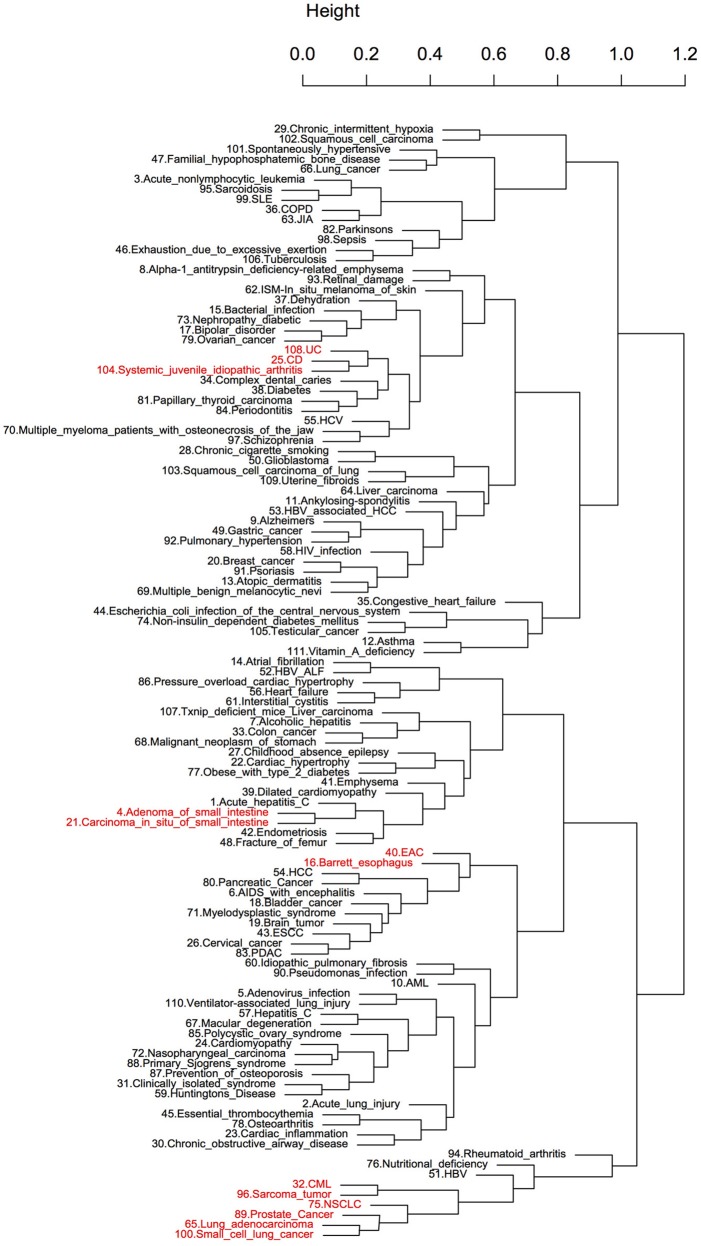
Hierarchical clustering of diseases using diet-disease enrichment scores. The number before each disease name was used as a disease ID. The clustering is based on the enrichment scores of diseases across all foods. The clusters highlighted with red are known to share characteristic pathophysiology.